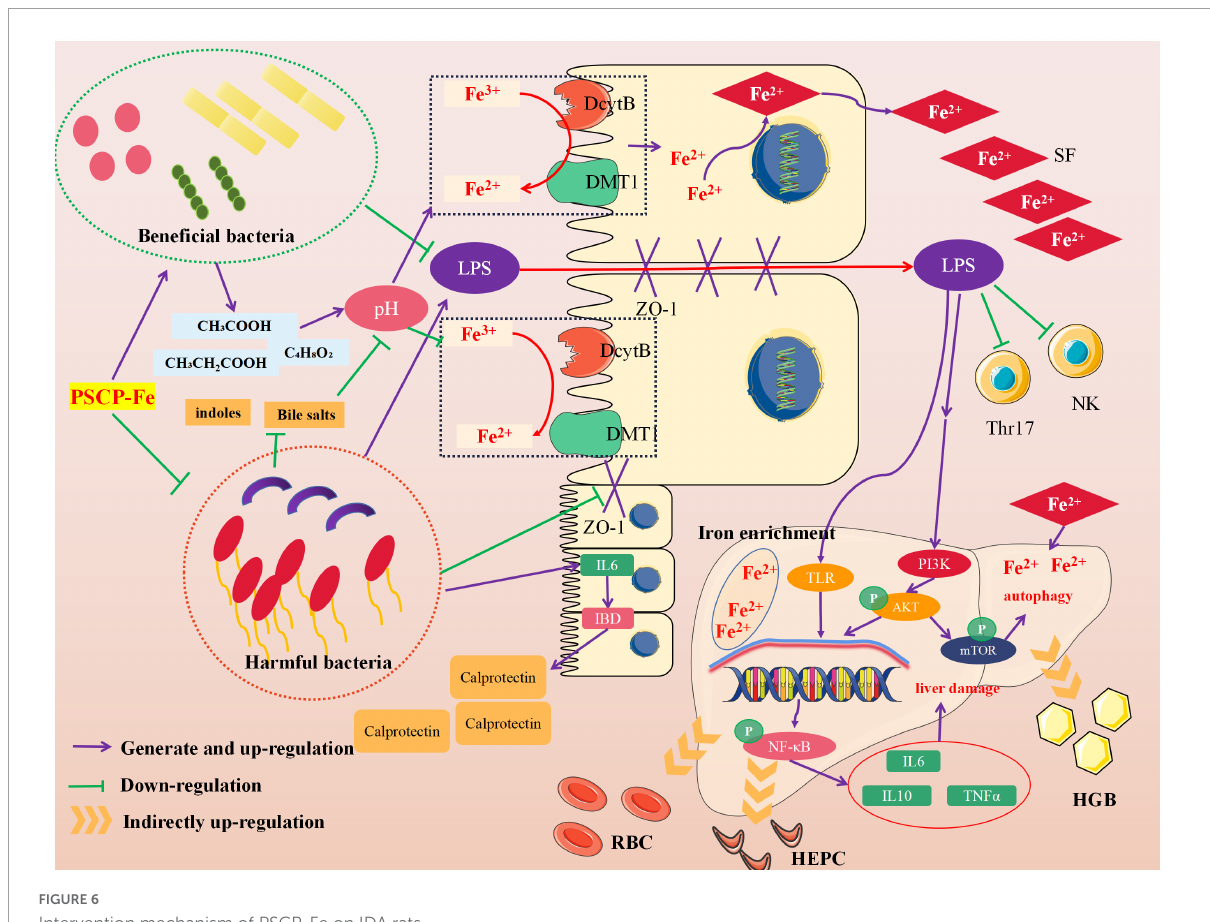
FIGURE6 Intervention mechanism of PSCP-Fe on IDA